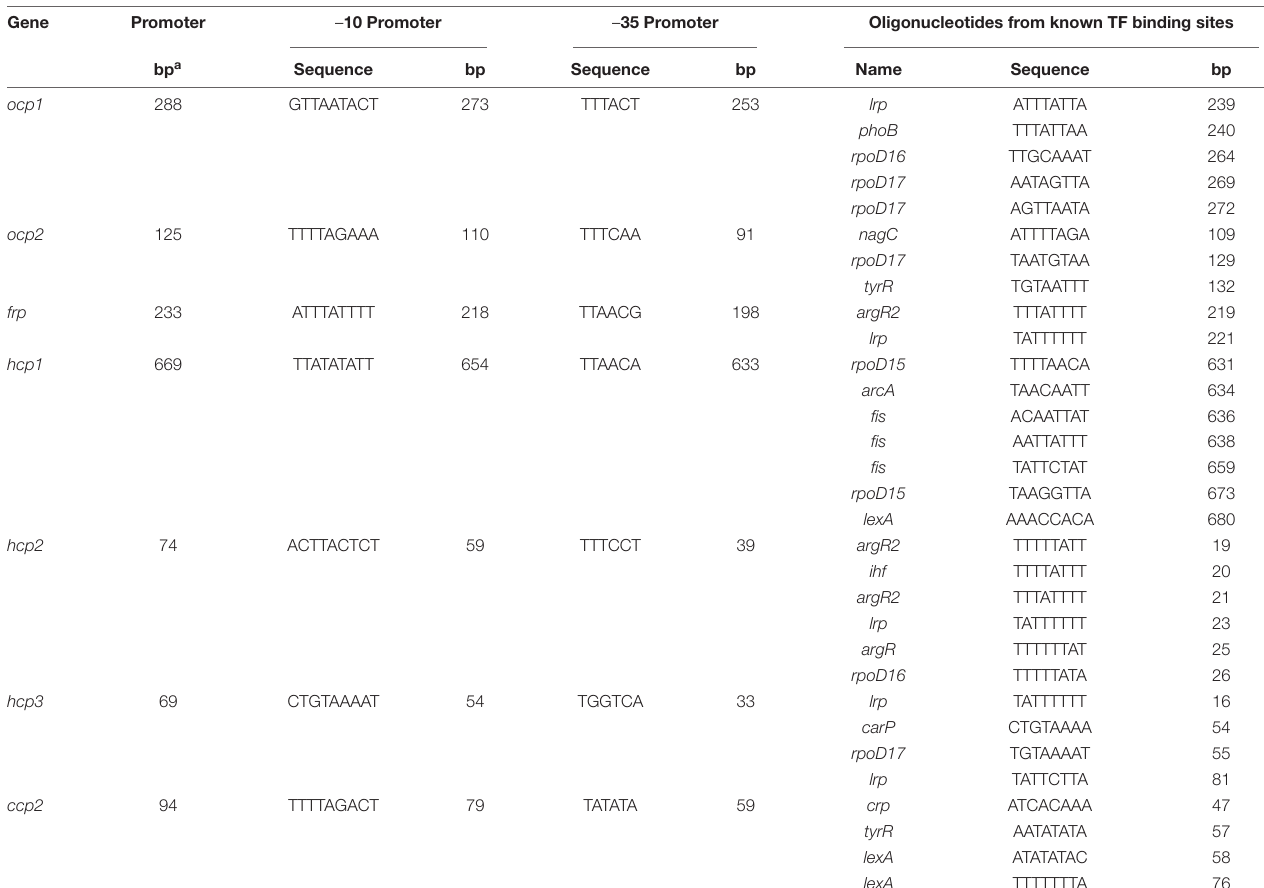
TABLE 3 | Promoter analyses for ocp homologs.